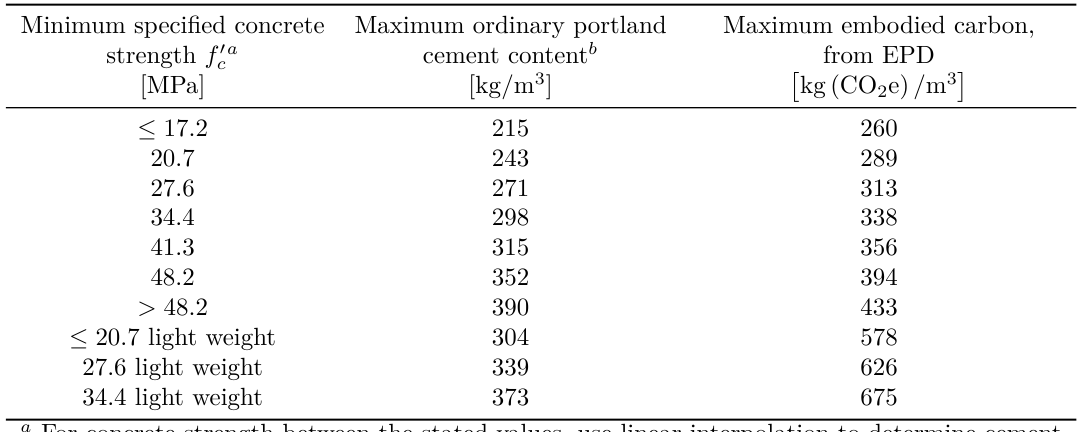
Table 1. Marin County cement and embodied carbon